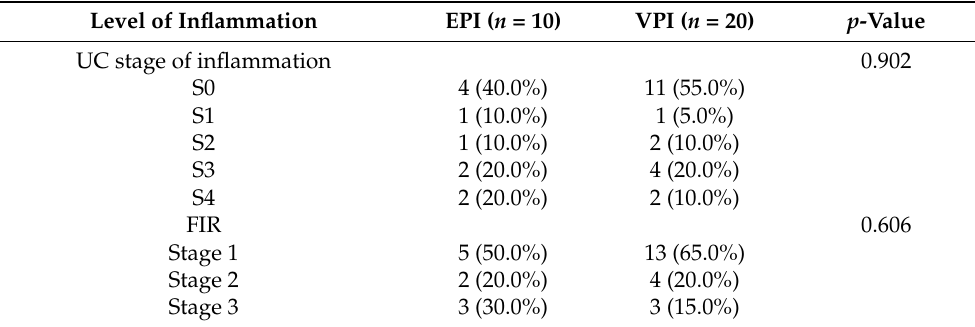
Table 4. Comparison of histopathology findings by level of